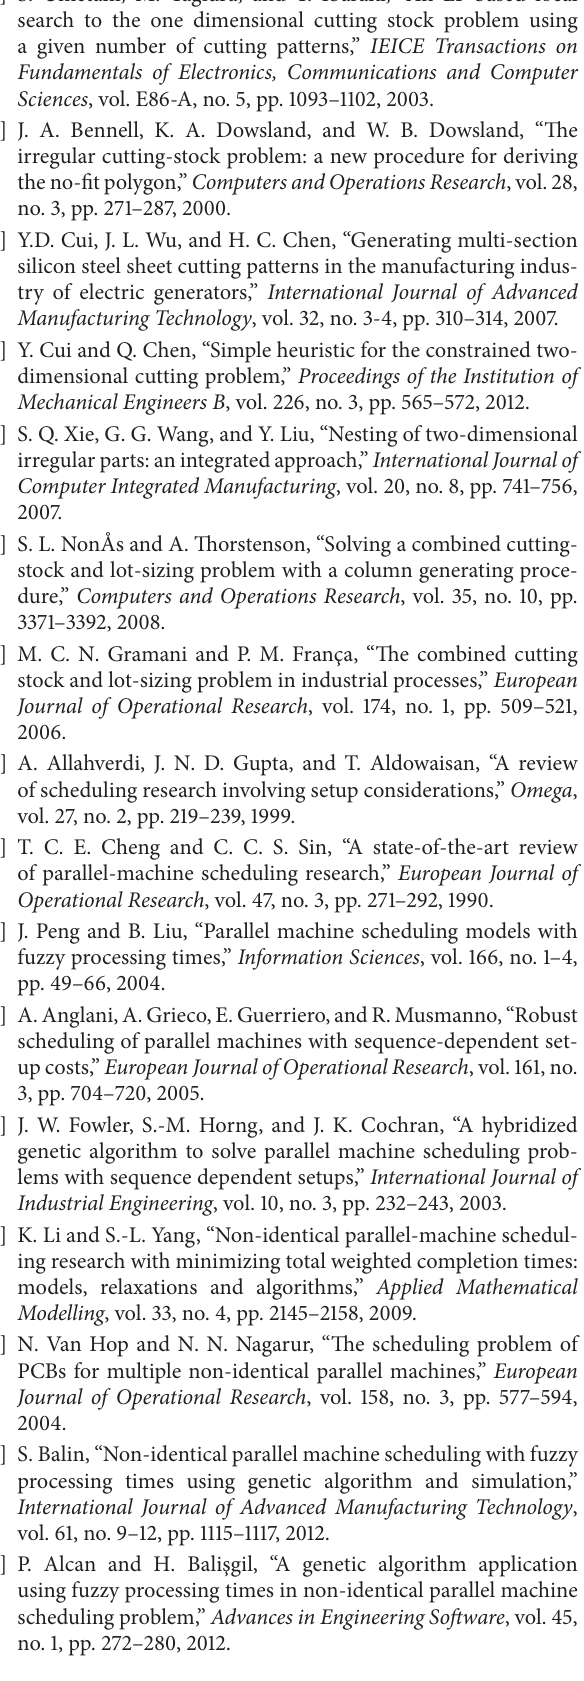
Figure 5: The Gantt chart of each cutting machine.